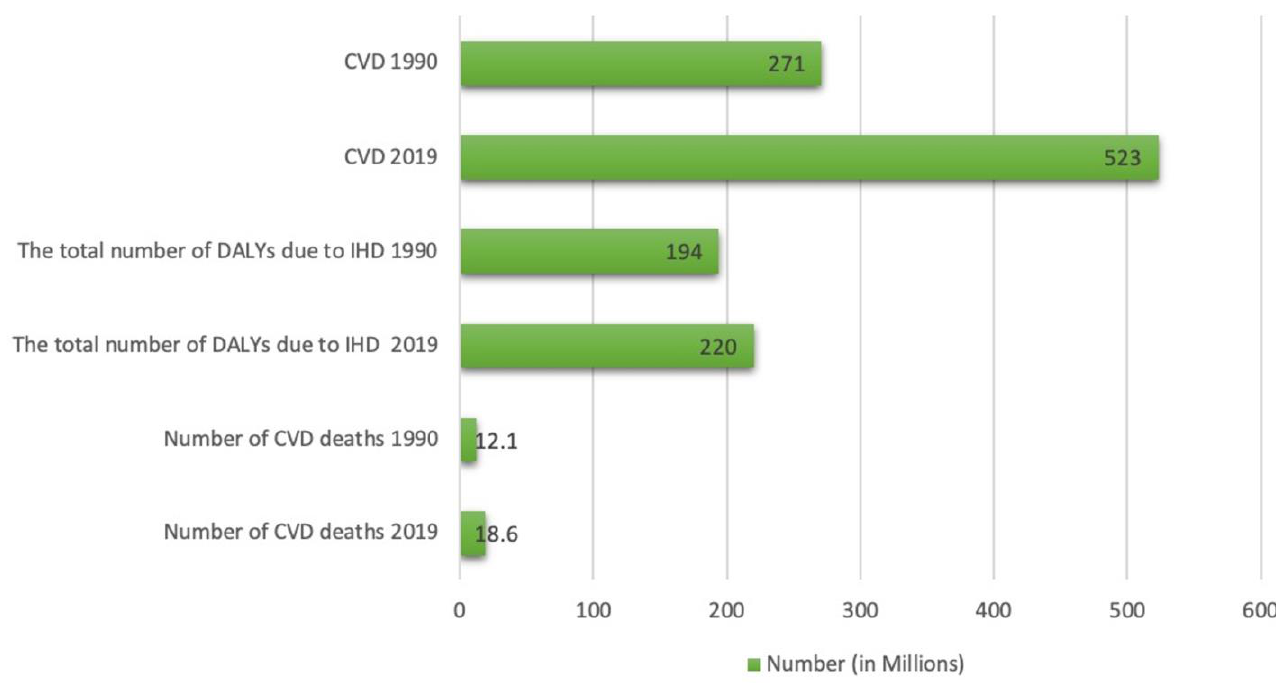
Figure 5. The incidence and mortality of cardiovascular diseases in the world from 1990 to 2019. It is known that NO plays an important role in cardioprotection in CVD. It exhibits various biological effects: relaxation of blood vessels, prevention of platelet aggregation, inhibition of leukocyte adhesion, and control of proliferation of vascular smooth muscle cells [69]. NO is produced by resident cardiac cells under stress and in large quantities by activated immune cells that enter the damaged myocardium. A deficiency of eNOS and nNOS exacerbates cardiac injury caused by ischemia/reperfusion or myocardial infarction [70]. NO activates soluble guanylate cyclase (sGC), which leads to an increase in cGMP levels and activation of cGMP-dependent protein kinase (PKG) [71]. In addition, NO induces the opening of mitochondrial K + -ATP channels and inhibits Ca 2+ overload (Figure 5) [72]. In addition, a mechanism has recently been described in which NO protects endothelial cells from oxidative stress-induced apoptosis by inhibiting cysteine-dependent superoxide dismutase (SOD1) monomerization and thus blocking its inactivation [73]. The diverse effects of CO are mainly explained by its regulation of general signaling pathways such as stimulation of sGC, opening of Ca 2+ -activated large conductive K + channels (BKCa), and activation of mitogen-activated protein kinase (MAPK) and protein kinase B (Akt). The apoptotic effects of CO are tissue-specific and cell-specific. For example, CO acts as an anti-apoptotic agent in endothelial cells [74] and cardiomyocytes [75], thus preventing cell damage. The anti-apoptotic effects of CO appear to be dependent on p38 activation [43,76], phosphorylation of the protein kinase R-like kinase of the endoplasmic reticulum, and/or via Akt activation [77]. CO has been shown to prevent TNF- α [78] and endoplasmic reticulum (ER) stress-induced apoptosis through a p38 MAPK-dependent mechanism (Figure 6) [74].